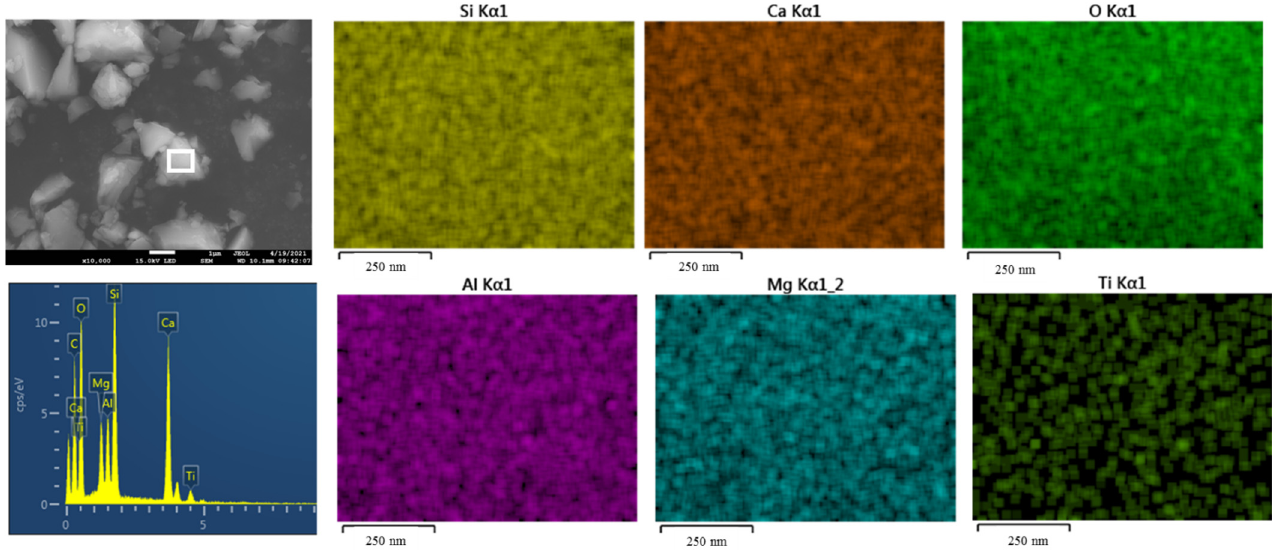
Figure 10. SEM–EDS analysis with mapping in the selected areas of BF slag with 7% MgO.